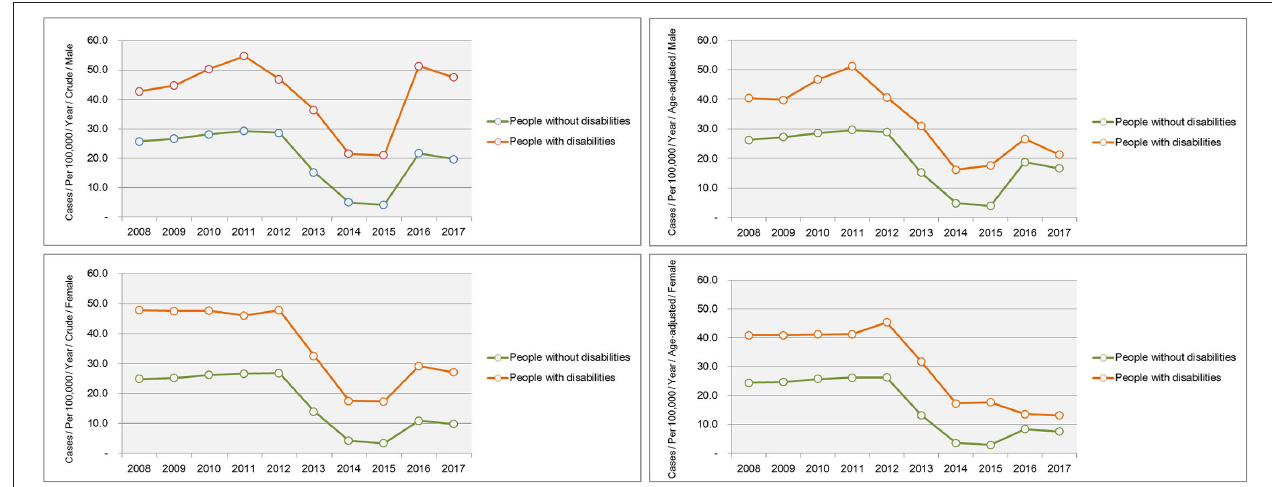
FIGURE 2 | Trends in the incidence of complicated appendicitis according to the presence and absence of a disability for 2008–2017.